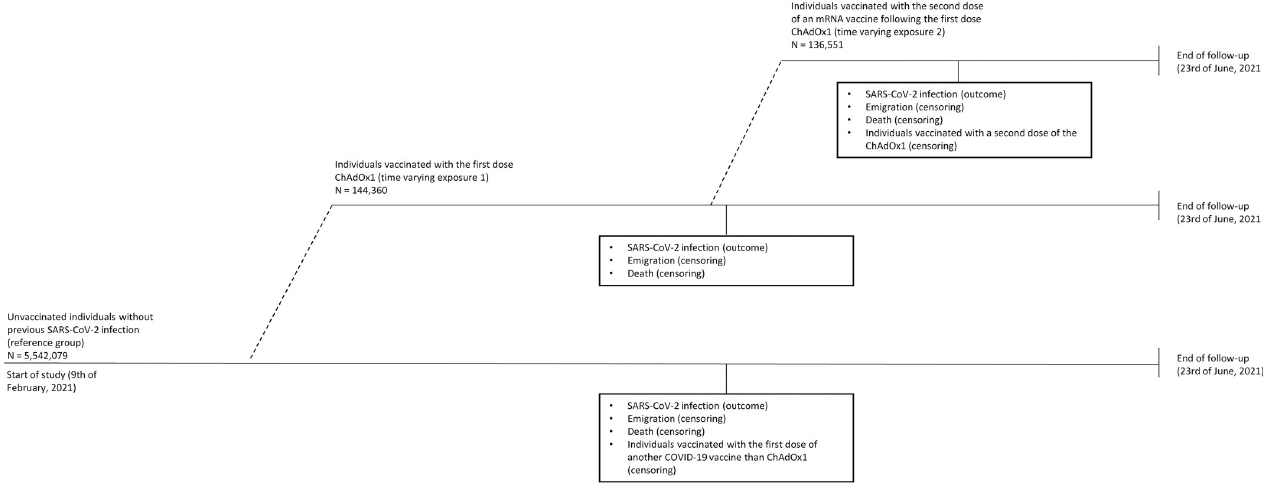
Fig 1. Flow chart of the study population. COVID AU : AbbreviationlistshavebeencompiledforthoseusedinFigs 1 (cid:0) 3 : Pleaseverifythatallentriesarecorrect : -19, Coronavirus Disease 2019; COVID-19, Coronavirus Disease 2019.